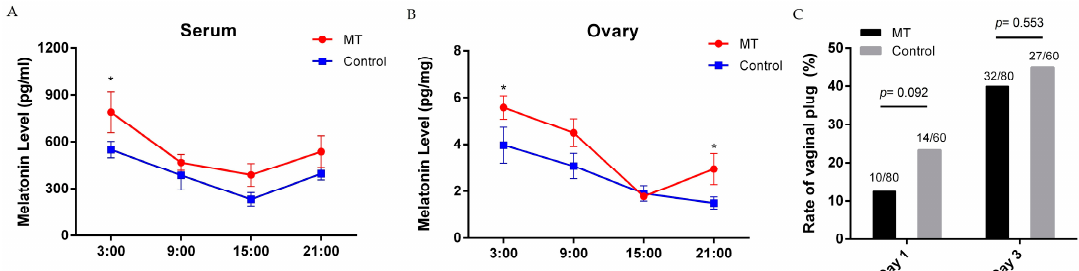
Figure 1. Melatonin levels and vaginal plug rate of the mice. ( A ) Serum melatonin levels at different time points (mean ± SEM, n = 7); ( B ) Ovarian melatonin levels at different time points (mean ± SEM, n = 7). Melatonin (MT): mice received 14-day melatonin treatment. Control: mice were without melatonin; ( C ) Vaginal plug rate. Day 1: the first day of the mating process. Days 1–3 represent the total accumulative vaginal plug rate from day 1 to day 3. Value p is based on the Pearson χ square test. “*” represents significant differences, p < 0.05.